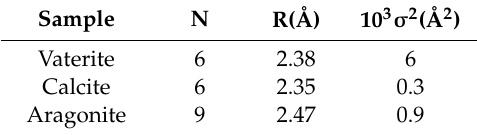
Table A1. The first coordination shell (Ca-O 1 ) fitting results of three references, vaterite, calcite,